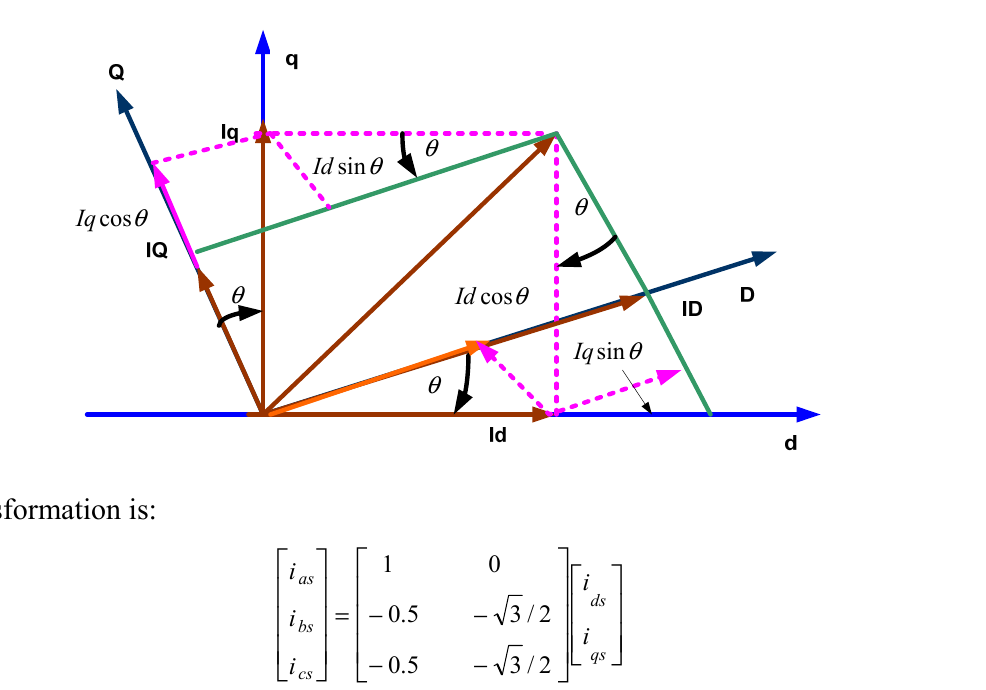
Figure 2. Park transformation principle.